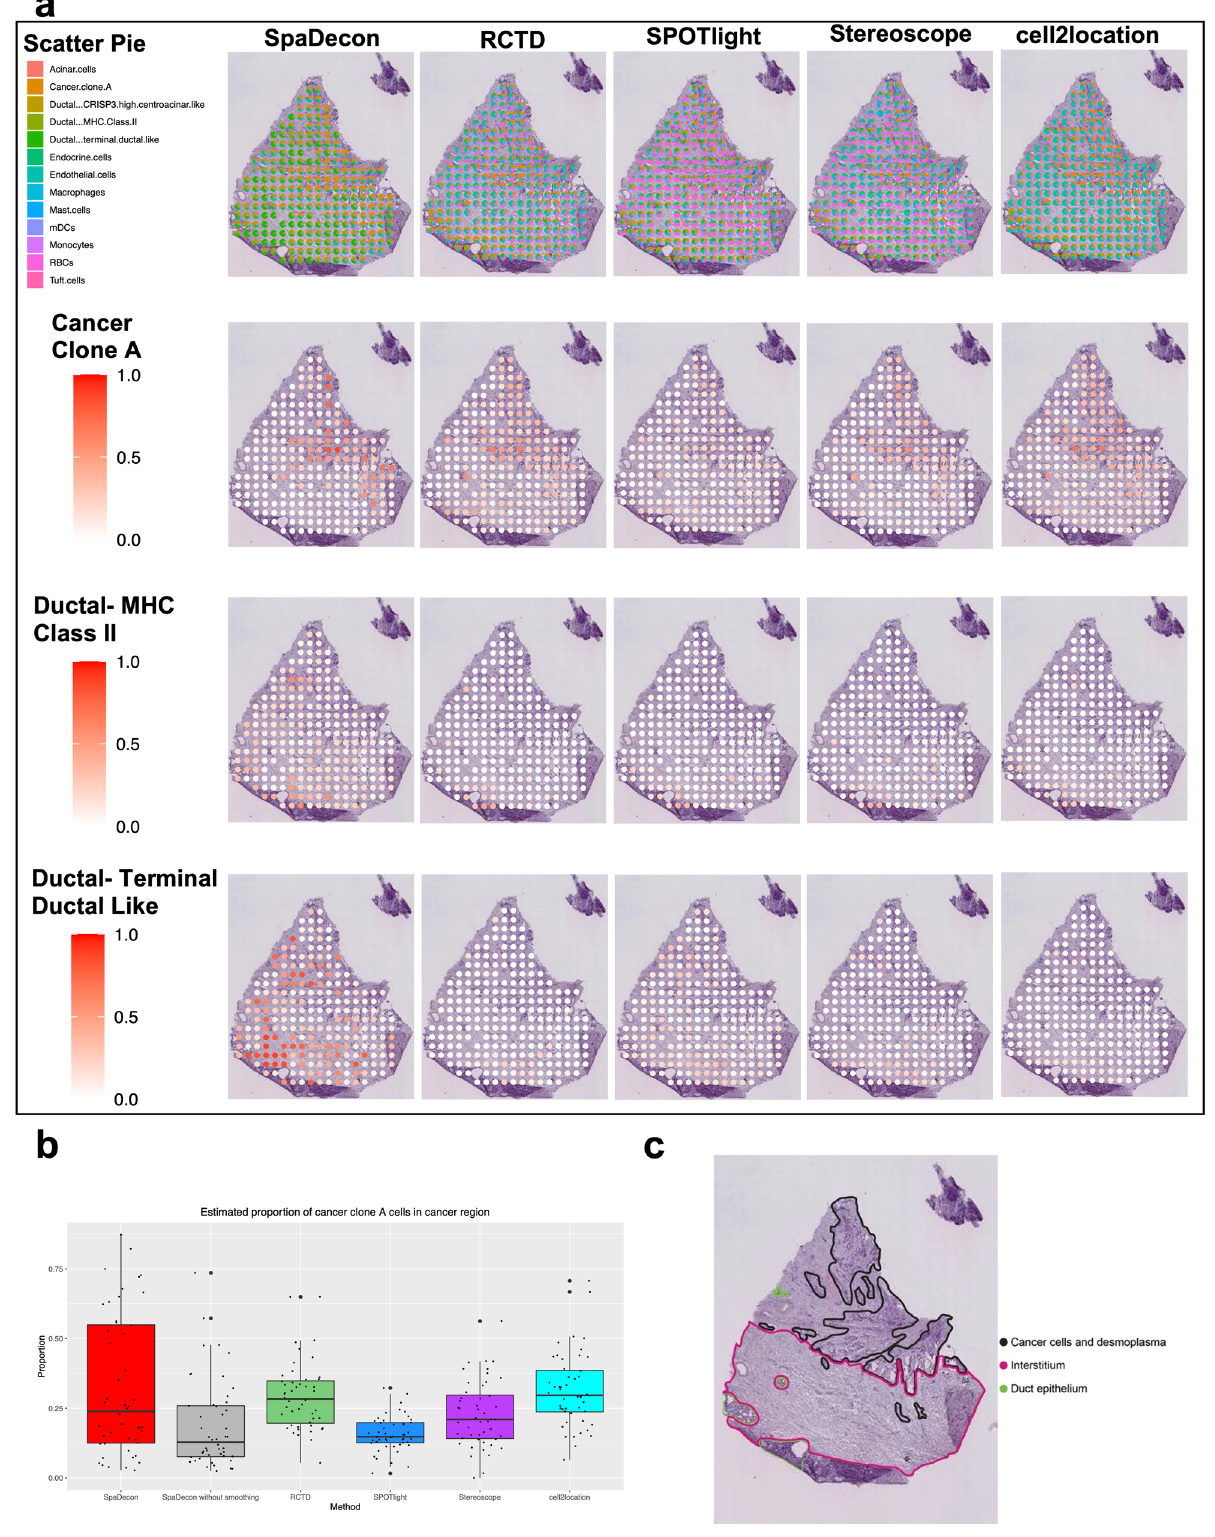
Fig. 5 Cell-type deconvolution results for pancreatic ductal adenocarcinoma ST data. a Scatter pie plots displaying the cell-type proportion estimates of SpaDecon, RCTD, SPOTlight, Stereoscope, and cell2location at each spot, along with heatmaps showing the estimated distributions of cancer clone A, ductal- MHC Class II, and ductal- terminal ductal like cells. b Boxplot showing the proportions of cancer cells estimated by each method across spots in the cancer cell-rich regions ( n = 48 spots). c Manual annotation of cancerous pancreas tissue section from which ST data were